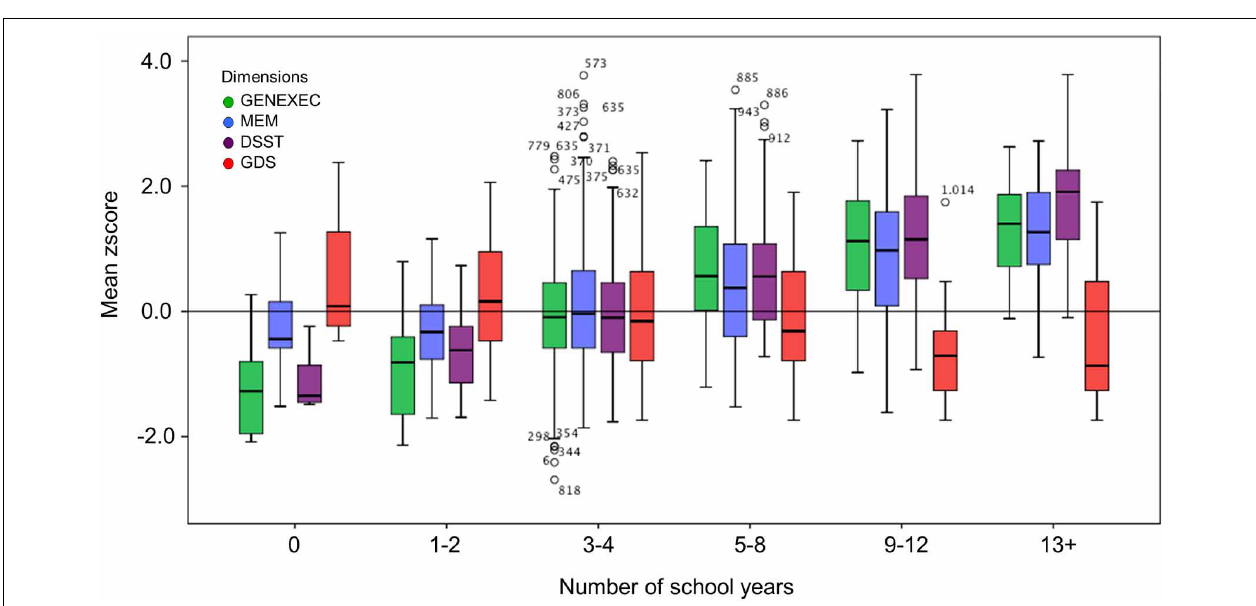
FIGURE 3 | Box-and-Whisker plots for cognitive and mood performance in the six school groups (0, 1–2, 3–4, 5–8, 9–12, and 13 + school years). First quartile, median, third quartile, interquartile range, outliers, and boundaries for outliers) are represented.